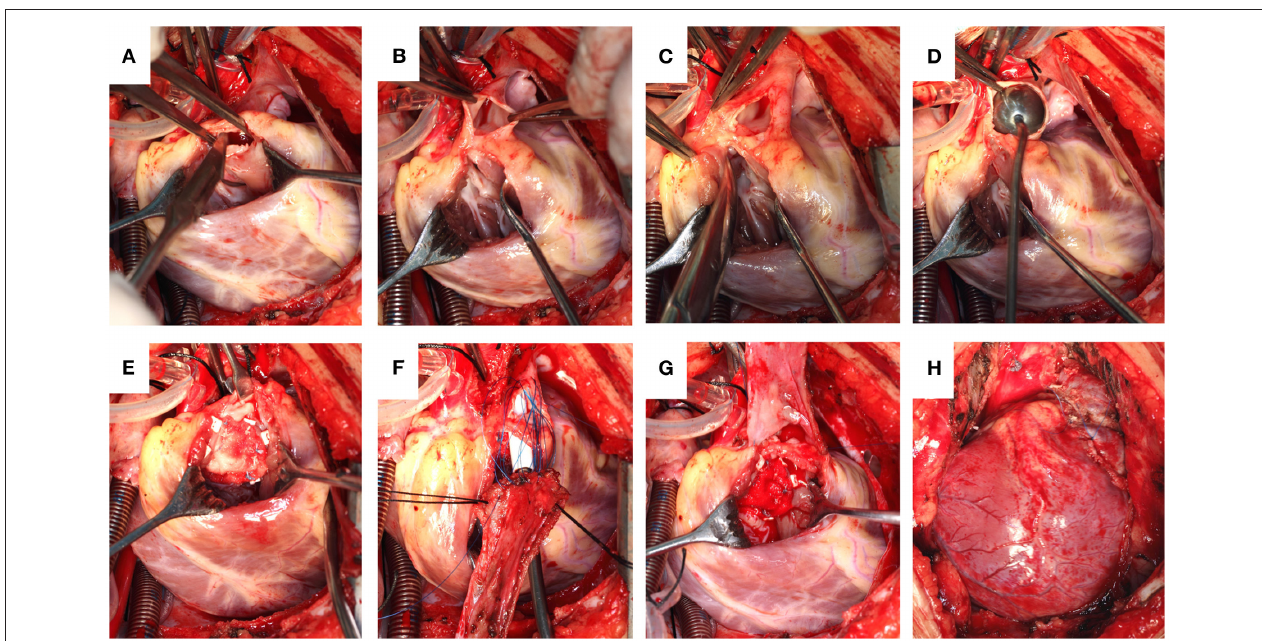
FIGURE 1 | (A) Pulmonary valve commissurotomy performed via a right ventricular incision. (B) The pulmonary artery incised, reserving the integrity of the pulmonary valve annulus. (C) Partially separated pulmonary valve annulus from the pulmonary wall. (D) Size of the distal pulmonary artery explored. (E) Repaired ventricular septal defect. (F) A piece of the autologous pericardium used to widen the RVOT with a sucker held deep into the pulmonary valve annulus to reveal the first orifice. (G) A soft autologous pericardial patch sutured continuously from the distal pulmonary incision to the RV. (H) Completed reconstruction.